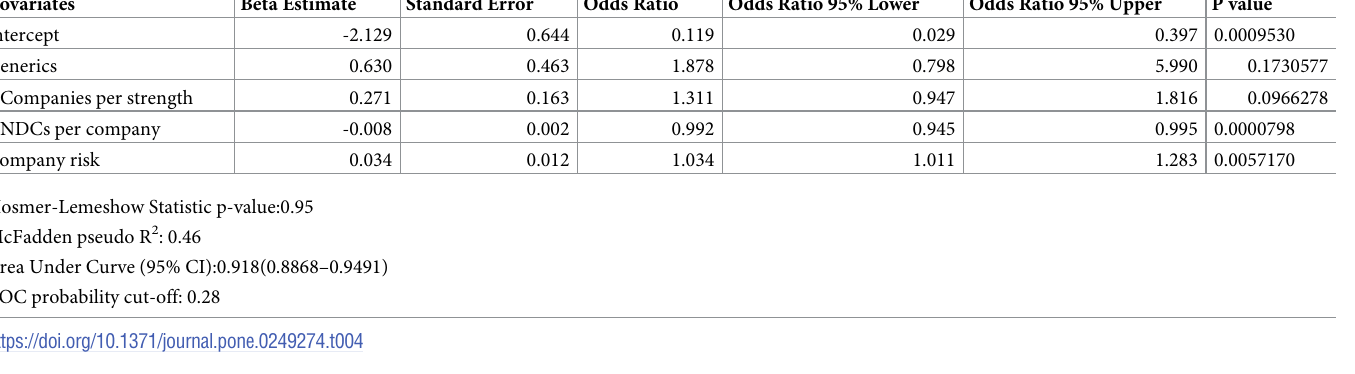
Table 4. Multivariable logistic regression model for predicting risk of shortage of opioid analgesics.